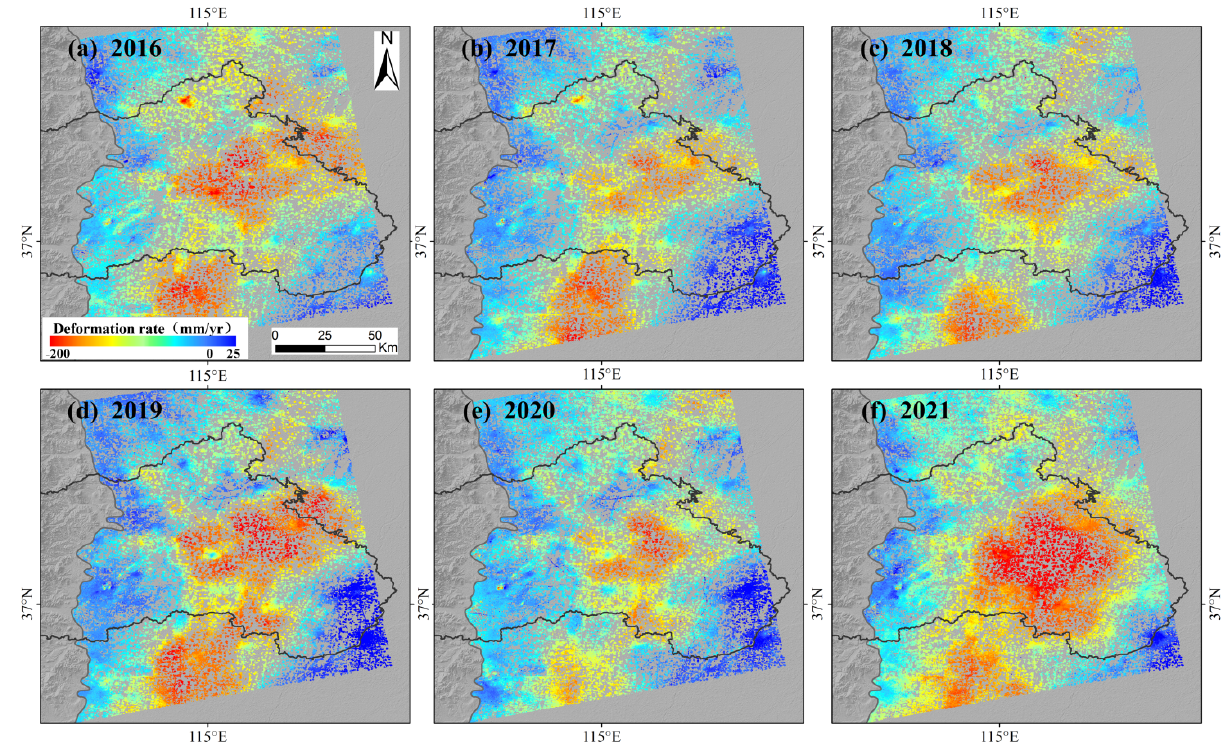
Figure 5. The maps of annual deformation rate over Xingtai plain in ( a – f ) 2016~2021.